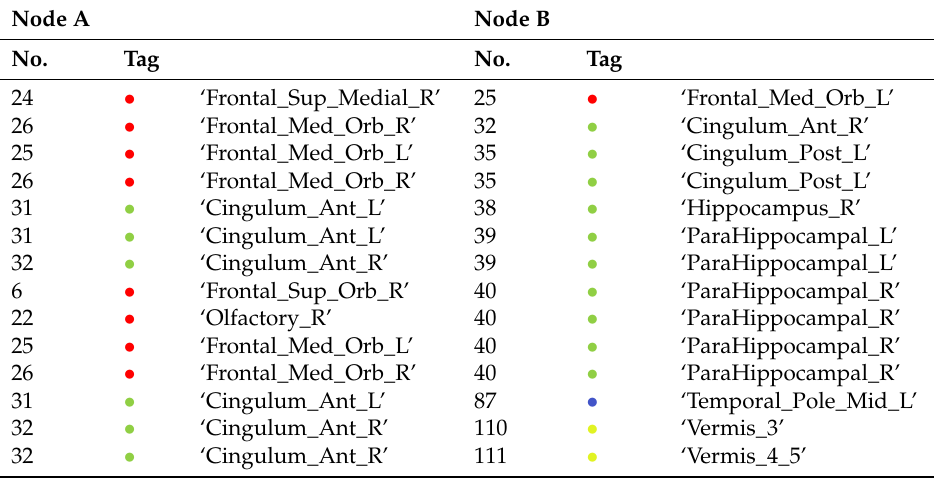
Table A2. List of the 14 links comprised in the underconnectivity network. Node A Node B